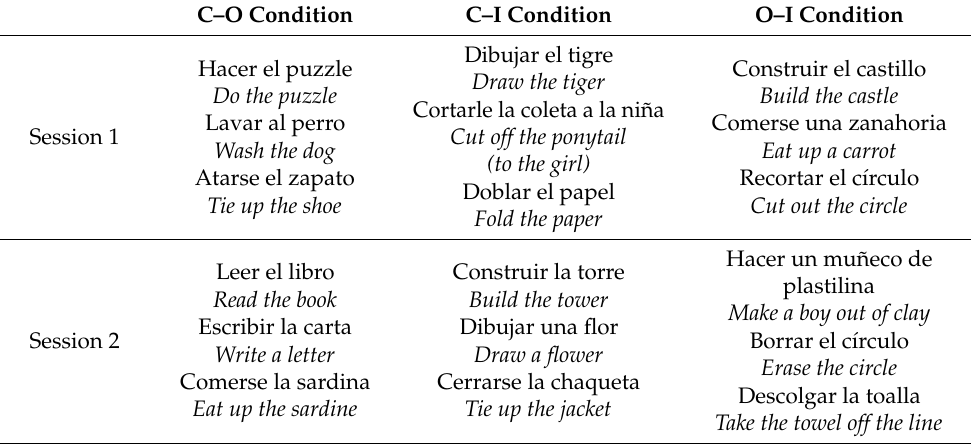
Table A1. List of predicates and test